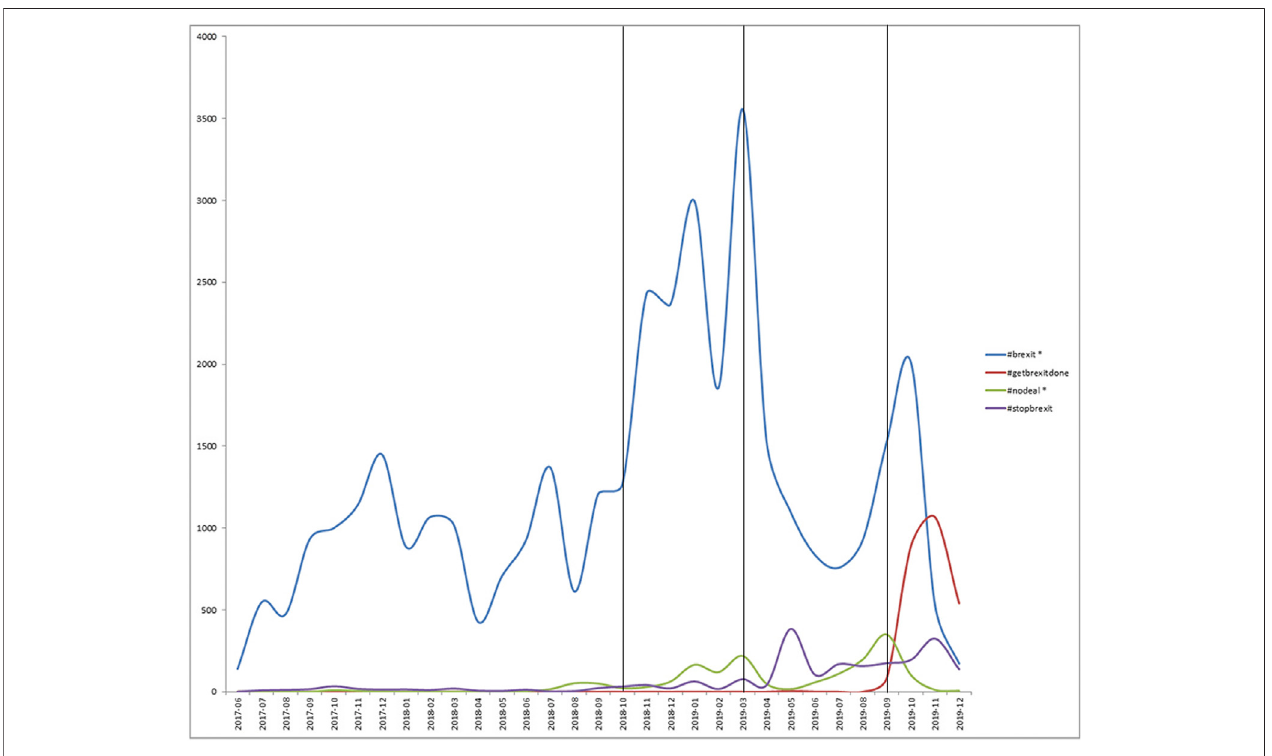
FIGURE 2 | Line graph showing the hashtag frequency over time. Hashtags denoted by * also include derivatives of that hashtag as a word stem.